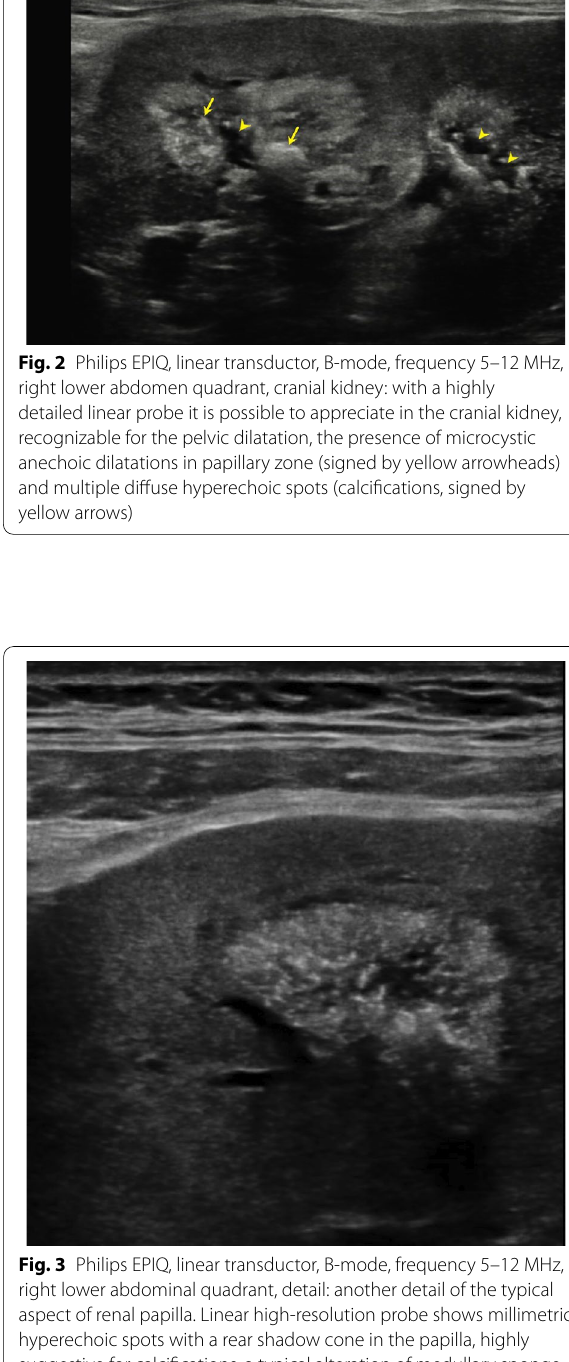
Fig. 3 Philips EPIQ, linear transductor, B-mode, frequency 5–12 MHz, right lower abdominal quadrant, detail: another detail of the typical aspect of renal papilla. Linear high-resolution probe shows millimetric hyperechoic spots with a rear shadow cone in the papilla, highly suggestive for calcifications, a typical alteration of medullary sponge